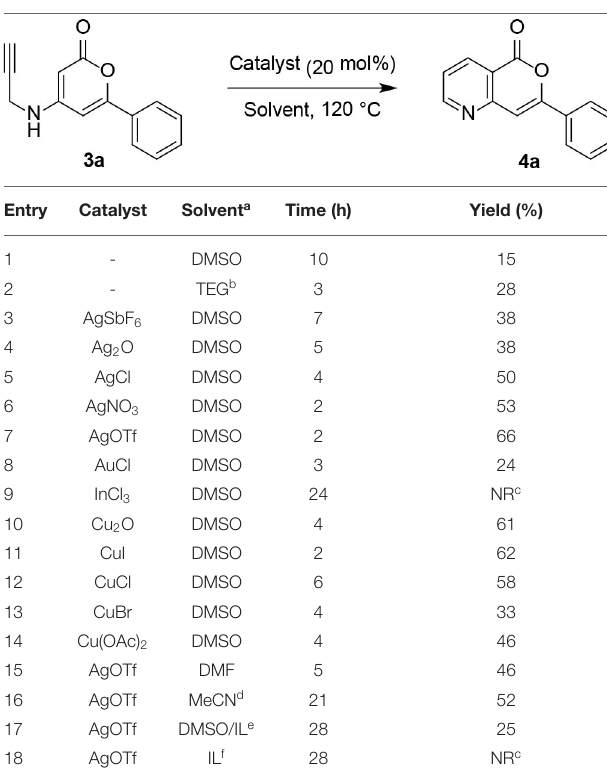
TABLE 1 | Investigation of reaction conditions for the cycloisomerization of 3a